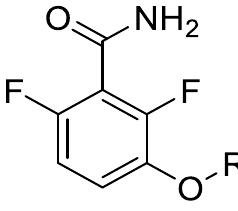
Table 1. Minimum inhibitory concentration (MIC) of the MST compounds on S. aureus and E. faecium .